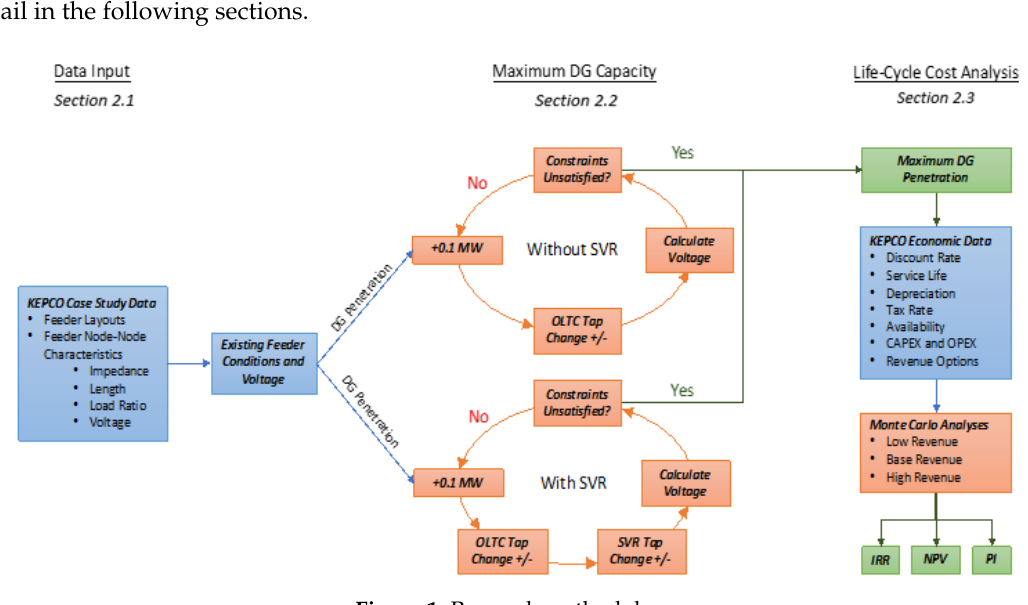
Figure 1. Research